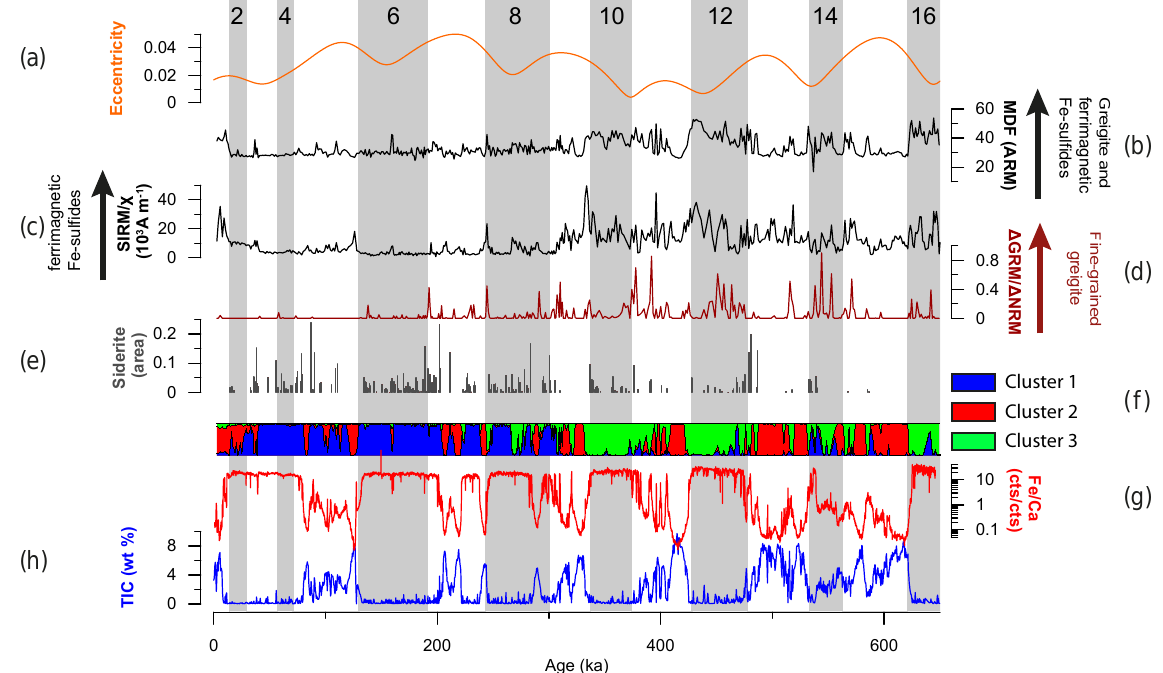
Figure 5. Compilation of parameters indicative of early diagenetic Fe-mineral formation, compared to (a) eccentricity (after Laskar et al., 2004). MDF (ARM) (b) , SIRM /χ (c) and (cid:49) GRM /(cid:49) NRM (d) are elevated in the lower part, while siderite abundances (e) are higher in the upper part of the core. Cluster-membership coefficients (f) imply a glacial–interglacial pattern for iron sulfides (green). Iron sulfides and siderites occur also at elevated Fe / Ca (g) ratios during interglacials. Geochemical differences between the upper and lower unit are also visible for TIC (h) concentrations during